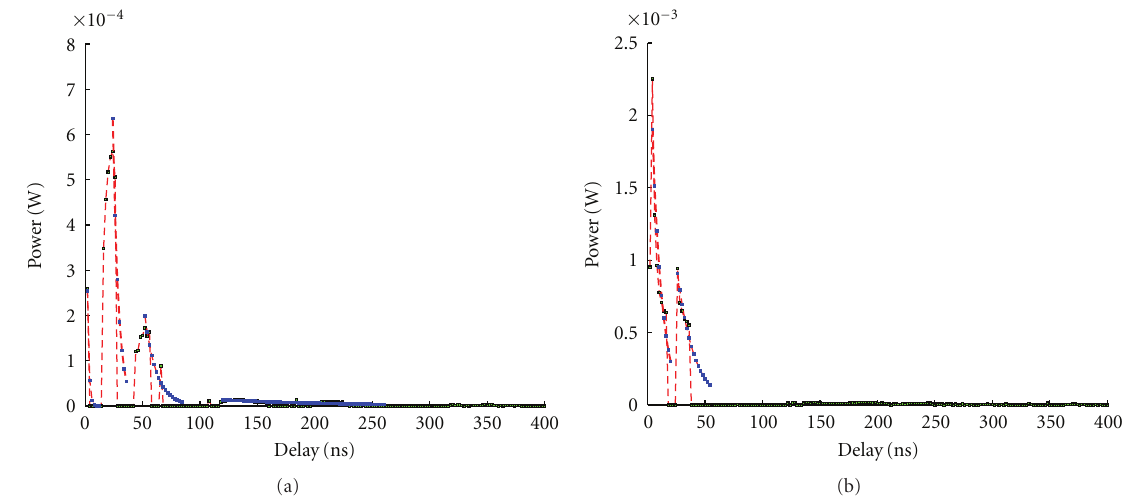
Figure 8: (a) Example where secondary cluster amplitude is larger than the LOS cluster (0ns cluster) and (b) where the DPP follows the SV model (the same room and frequency but di ff erent position).